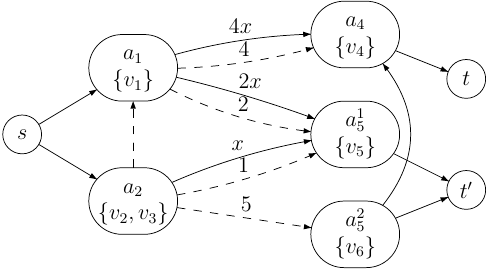
Figure 3. A refinement of the network in Figure